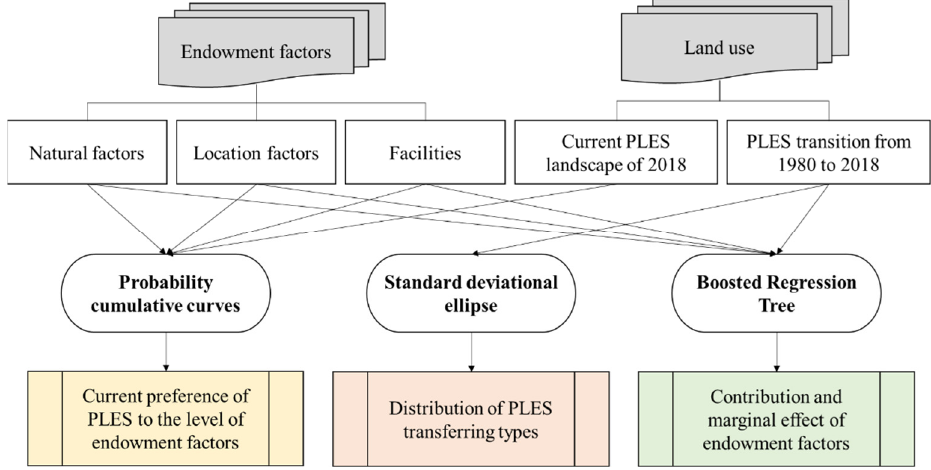
Figure 2. Technology roadmap.